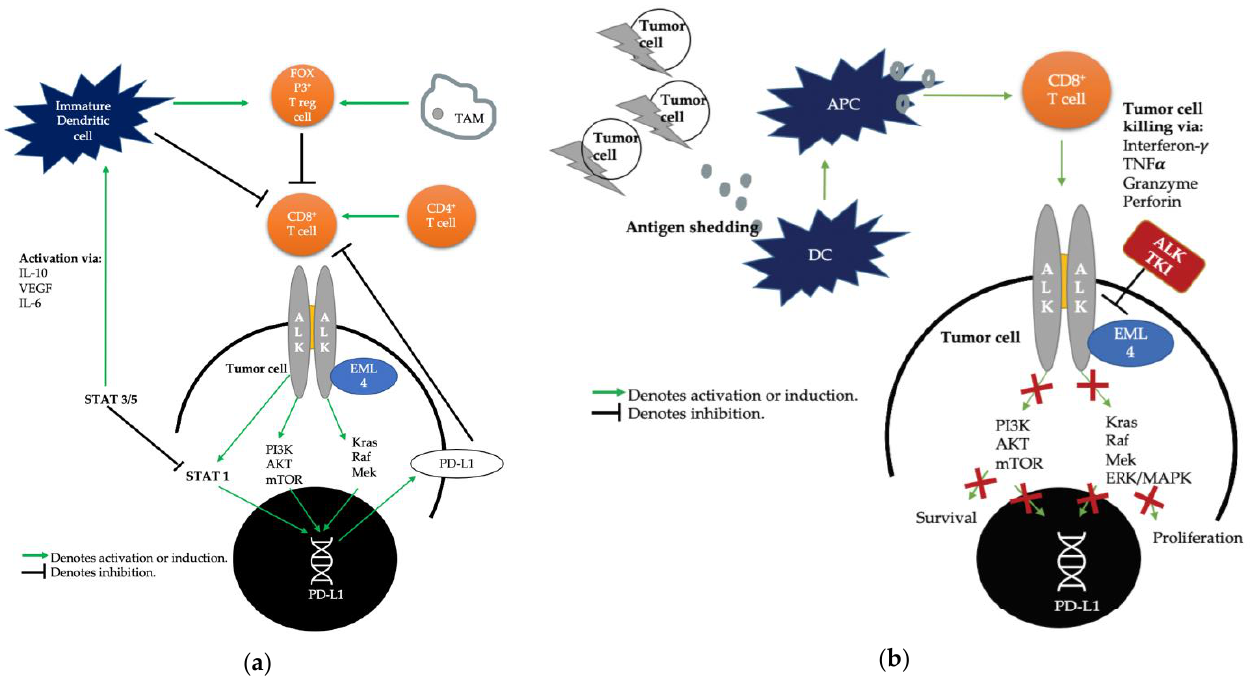
Figure 2. ( a ) Tumor microenvironment in ALK -rearranged non-small cell lung cancer. ( b ) Tumor microenvironment in ALK -rearranged non-small cell lung cancer in presence of ALK TKI. IL-10: Interleukin 10. IL-6: Interleukin 6. STAT3/5: Signal transducer and activator of transcription 3 and 5. PI3K: Phosphoinositide 3-kinase. AKT: protein kinase B. mTOR: mechanistic target of rapamycin. Kras: Kirsten rat sarcoma. Raf: Rapidly accelerated fibrosarcoma. Mek: mitogen-activated protein kinase. ERK/MAPK: extracellular signal-regulated kinase/mitogen-activated protein kinase. APC: antigen-presenting cell. DC: Dendritic cell.